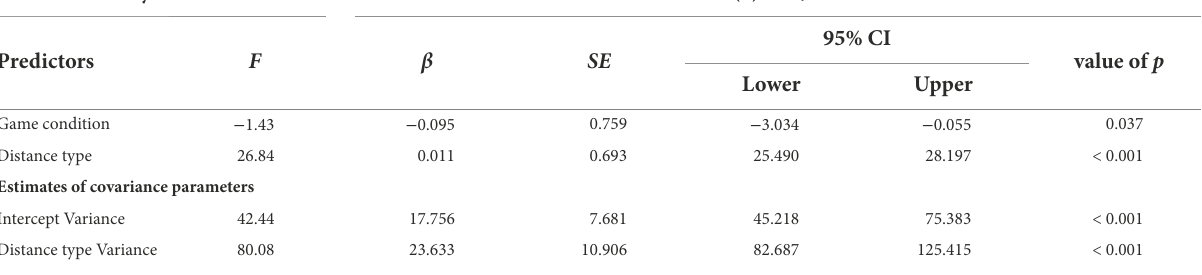
TABLE 3 Summary of linear mixed model analyses for the predictors game and distance type. Model